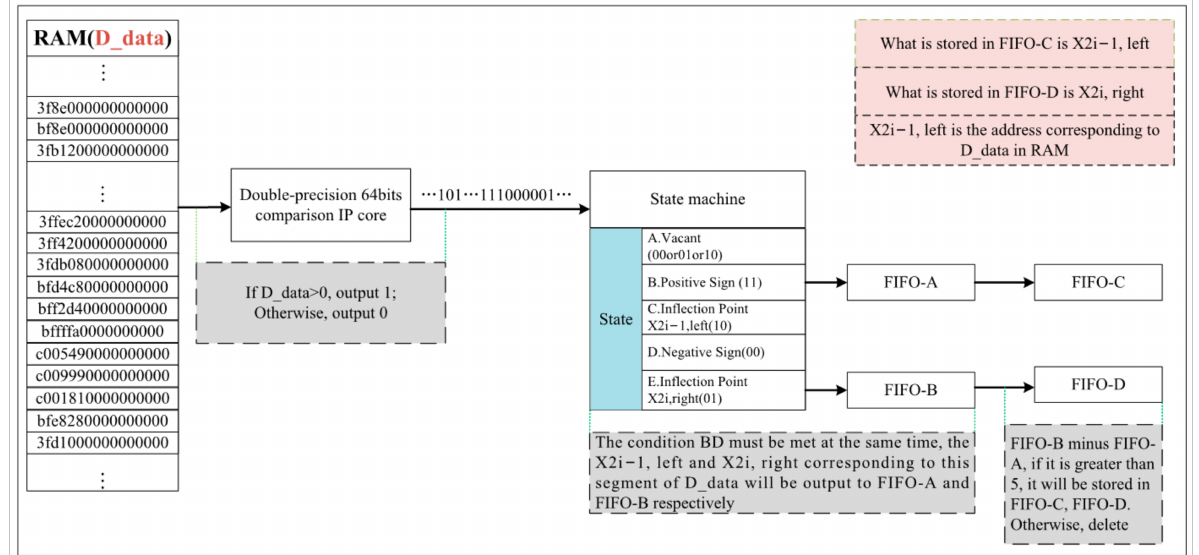
Figure 9. Inflection point coordinate query